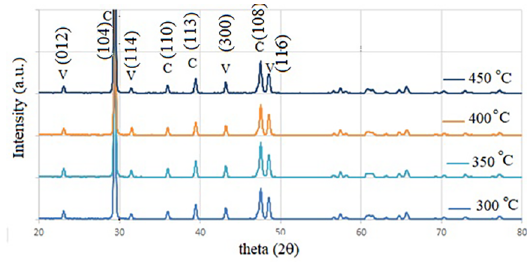
with different annealing 3